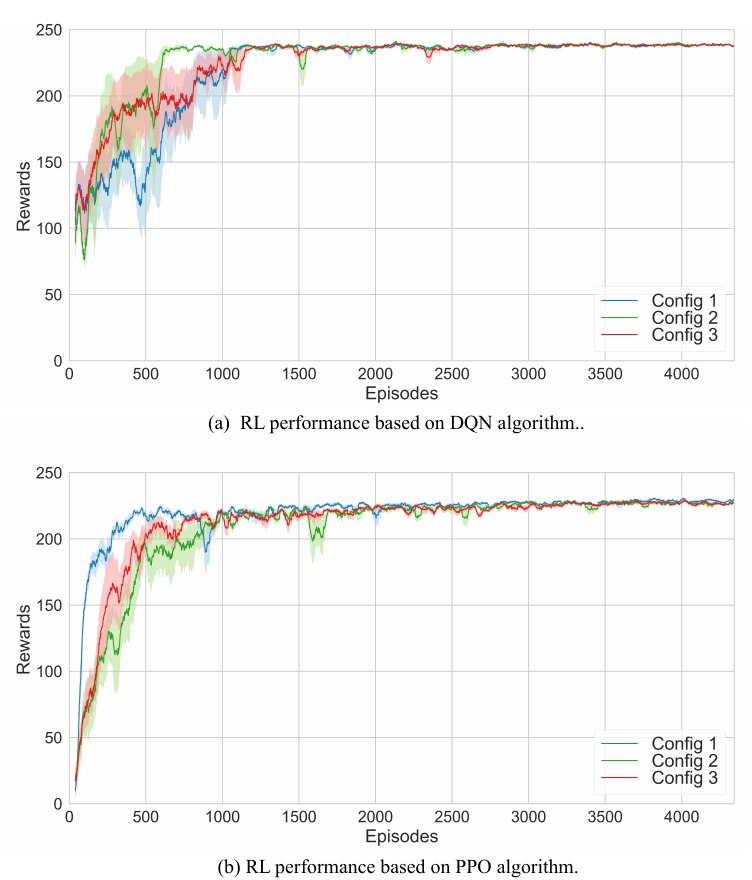
Figure 5. The influence of the SRL network configurations in mobile robot 2D navigation